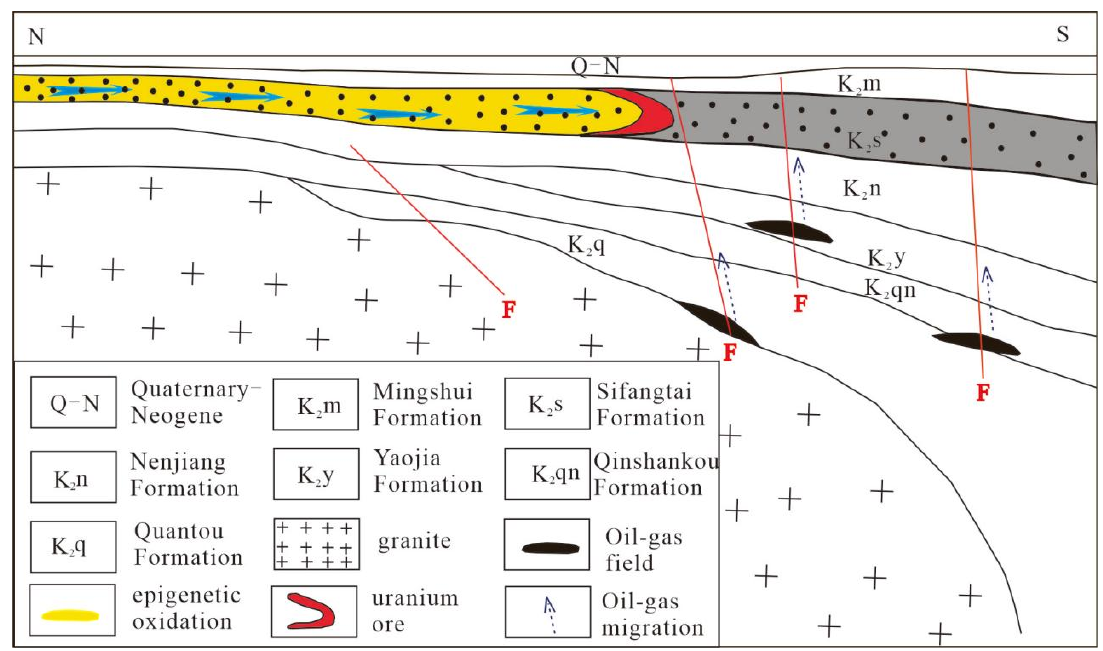
Figure 17. Uranium mineral model of the Sifangtai Formation in the northern part of the Songliao Basin.